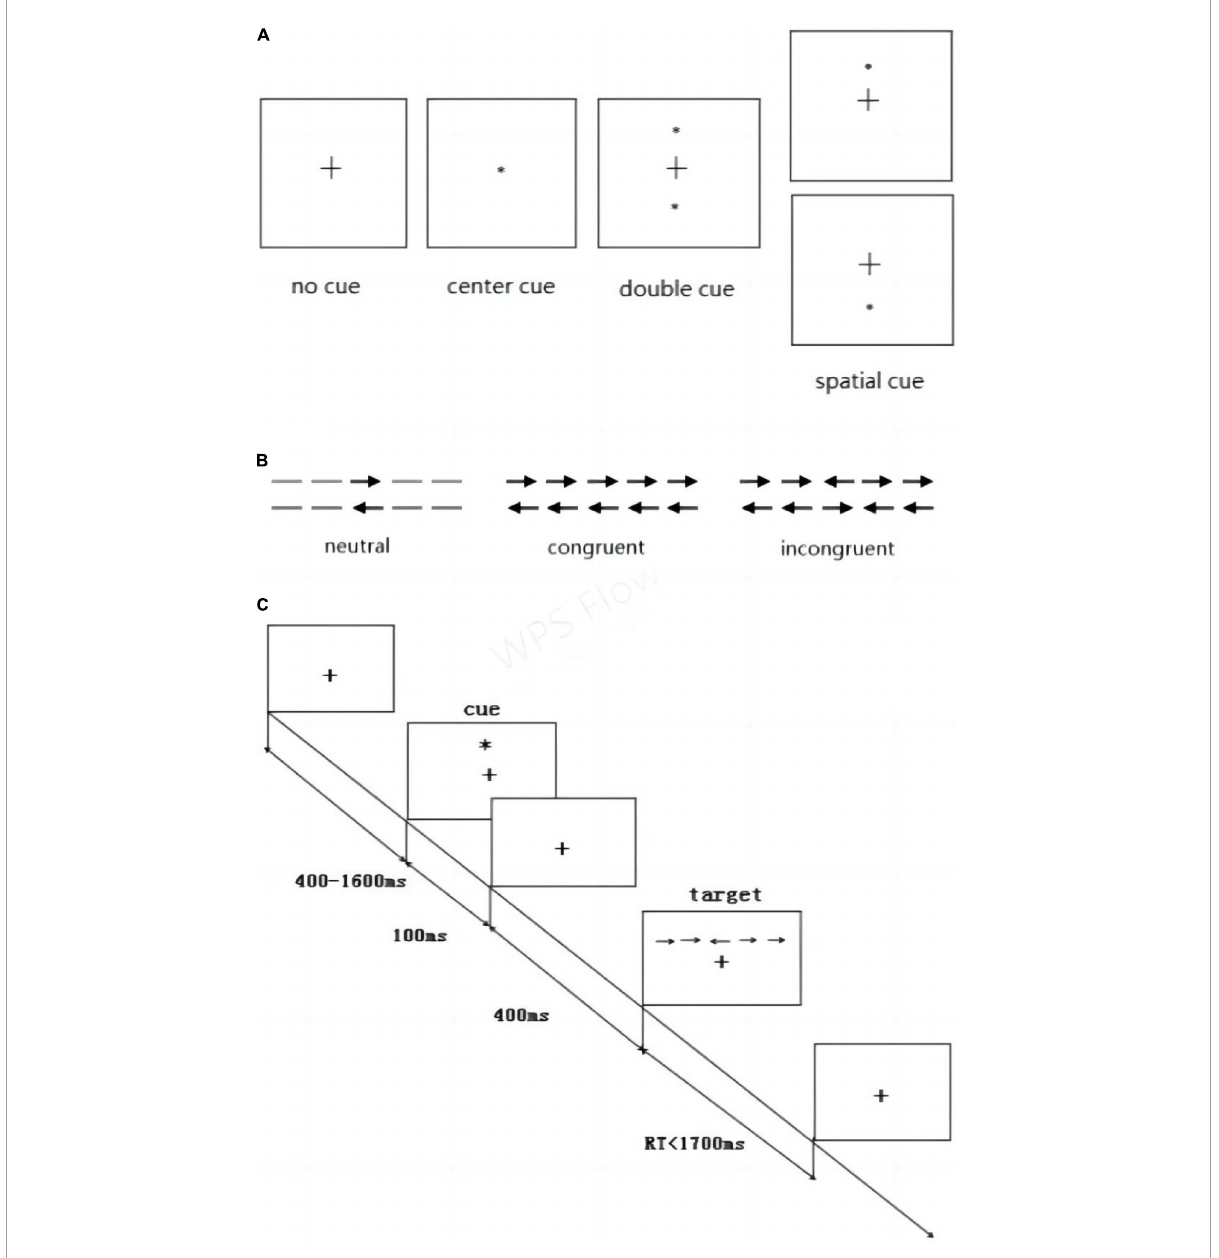
FIGURE3 Attention Network Test. (A) Four cue stimulus conditions and (B) three target stimulus conditions were used in the experiment. (C) Example of the